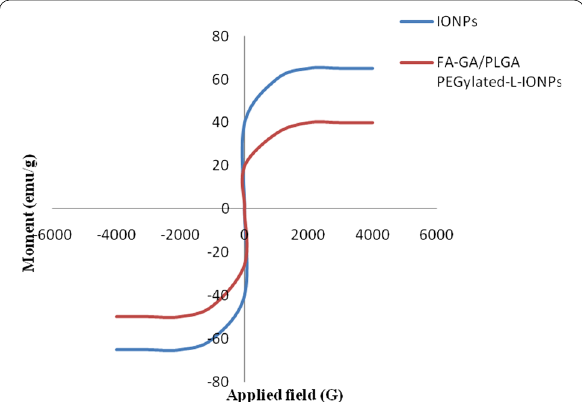
Fig. 8 Magnetic property study of IONPs, FA-GA